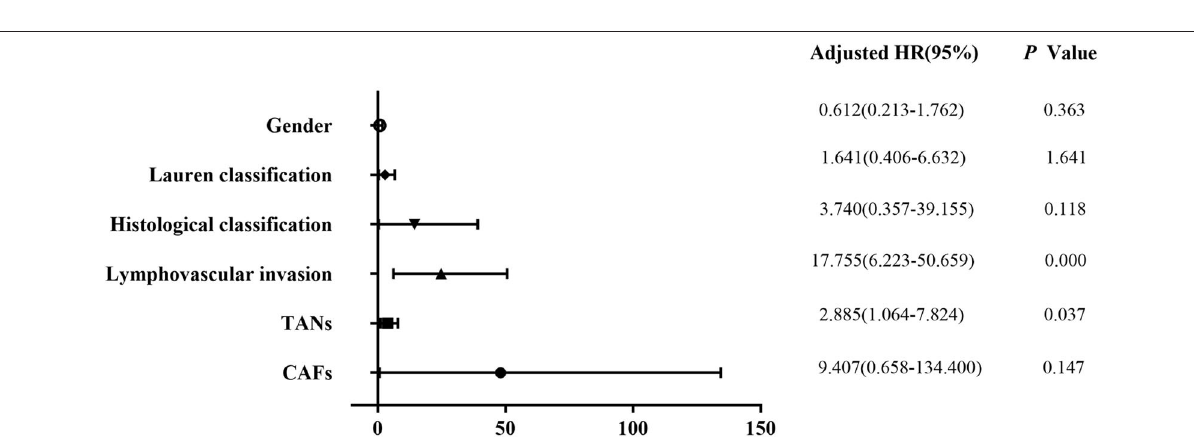
FIGURE 3 | Multivariate logistic regression analysis of potential risk factors for LNM in patients with submucosal EGC. Both LVI ( P = 0.000) and TANs ( P = 0.037) were the independent factors for LNM in patients with submucosal EGC.